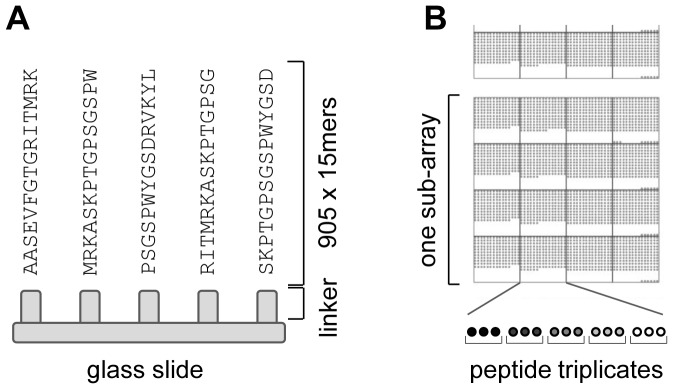
Design of the peptide chip ChloroPhos1.0.(A) Phosphopeptides for chloroplast proteins were extracted from published datasets by searching phosphoproteomics data with a chloroplast proteome reference table. Selected peptides were covalently connected to epoxy- functionalized glass slides via an N-(3-(2-(2-(3- amino-propoxy)-ethoxy)-ethoxy)-propyl)-succinamic acid linker at their N- terminus. The phosphorylation site as determined by mass spectrometry is located at the central amino acid residue in the 15 mer peptide. (B) Organization of peptides on the microarray. The microarray consists of 3 identical subarrays on which 905 chloroplast peptides plus additional control peptides are printed. In each sub-array, every peptide is spotted in triplicates. One peptide spot consists of ∼282 million single peptide molecules, with a spot diameter of 200 µm and an inter-spot separation of 300 µm.